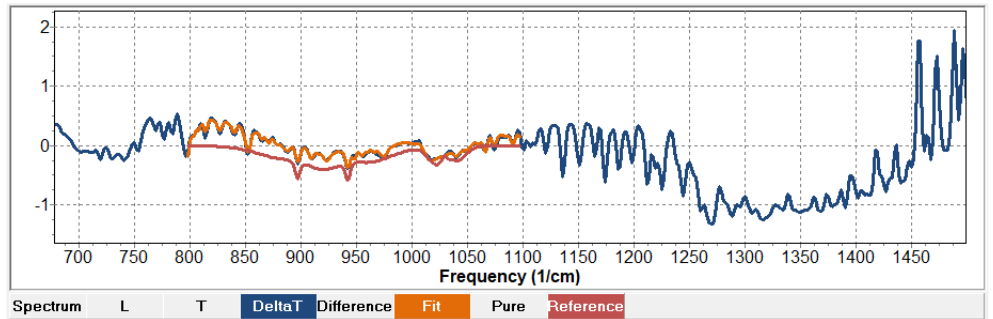
Figure 11. Delta T and the calculated result of the spectrum of vinyl chloride detected by the SIGIS-2 analysis.